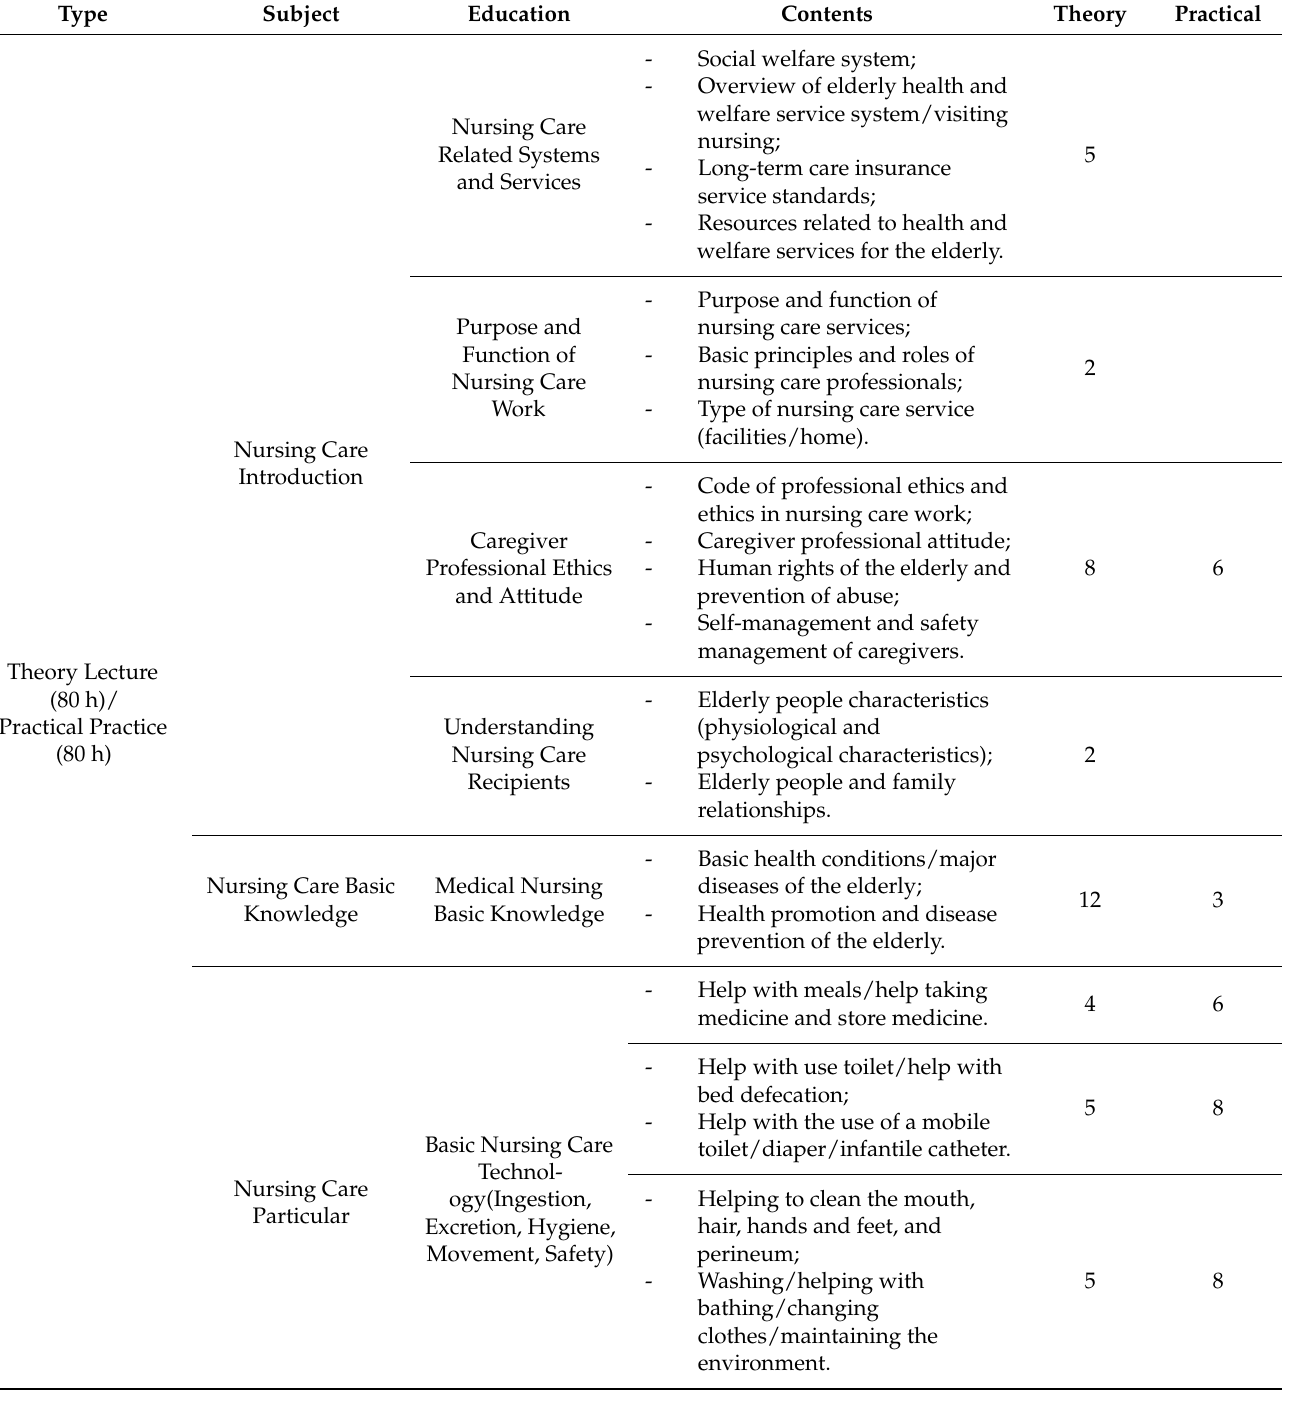
Table 1. Analysis of domestic caregiver training